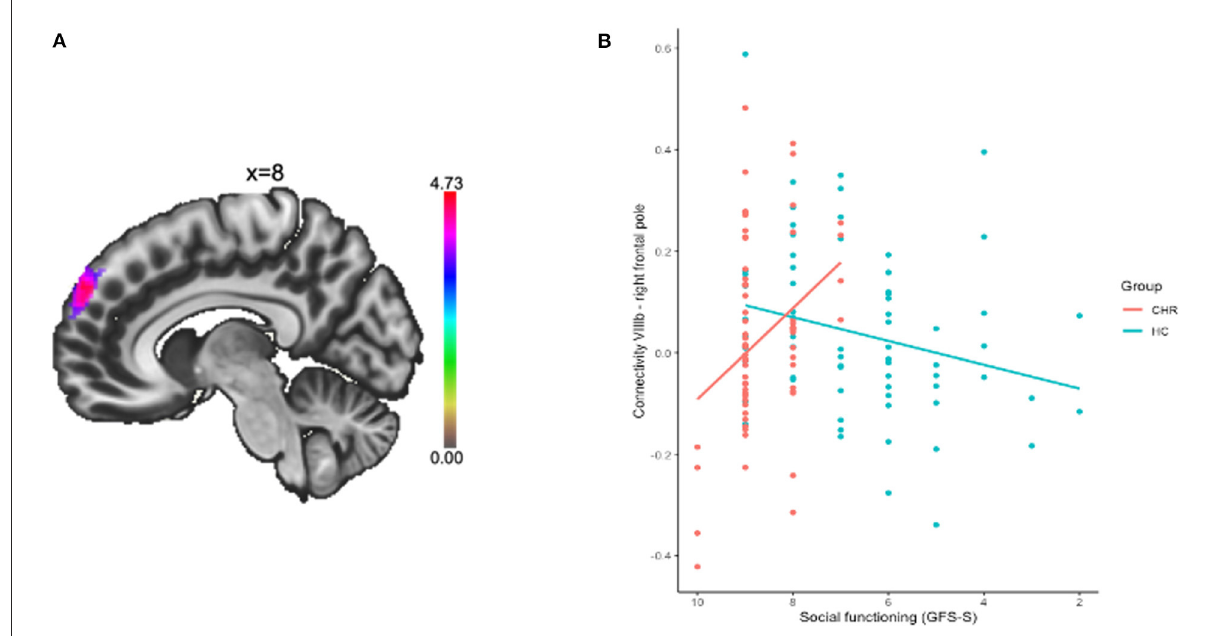
FIGURE2 Connectivity between lobule VIIIb and right frontal pole was related to social functioning. (A) Cluster in the right frontal pole is depicted. (B) Connectivity between the regions was extracted and plotted by group and social functioning